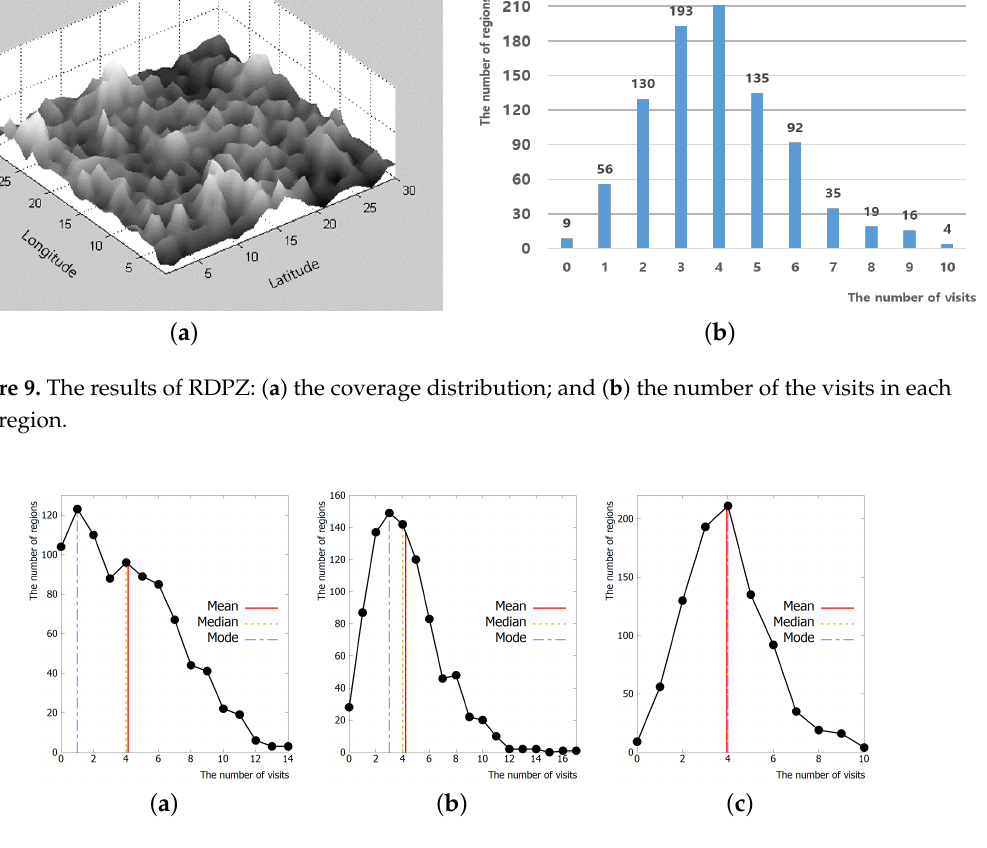
Figure 10. The comparisons of skewness: ( a ) Random Waypoint model; ( b ) Pheromone Repel model; and ( c ) RDPZ 15 × 15